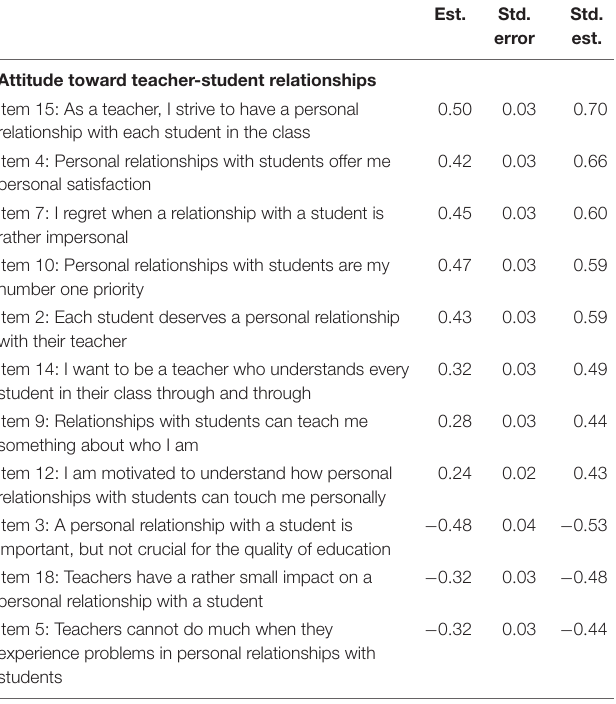
TABLE 6 | Results of confirmatory factor analysis for knowledge: EFA solution. Est. Std. Std. error est.